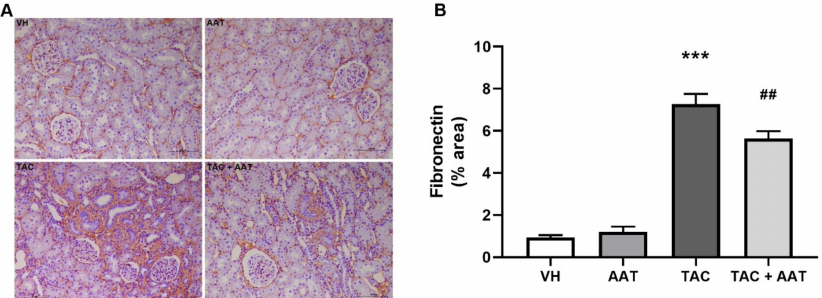
Figure 2. E ff ect of alpha-1 antitrypsin on fibronectin staining in tacrolimus-induced renal injury. ( A ) Immunohistochemical staining for fibronectin (200 × magnification). ( B ) Quantitative analysis of fibronectin staining area. Data are presented as means ± standard errors; *** p < 0.001 vs. VH; ## p < 0.01 vs. TAC. Abbreviations: VH, vehicle group; AAT, alpha-1 antitrypsin treatment group; TAC, tacrolimus treatment group; TAC + AAT, tacrolimus and alpha-1 antitrypsin cotreatment group.